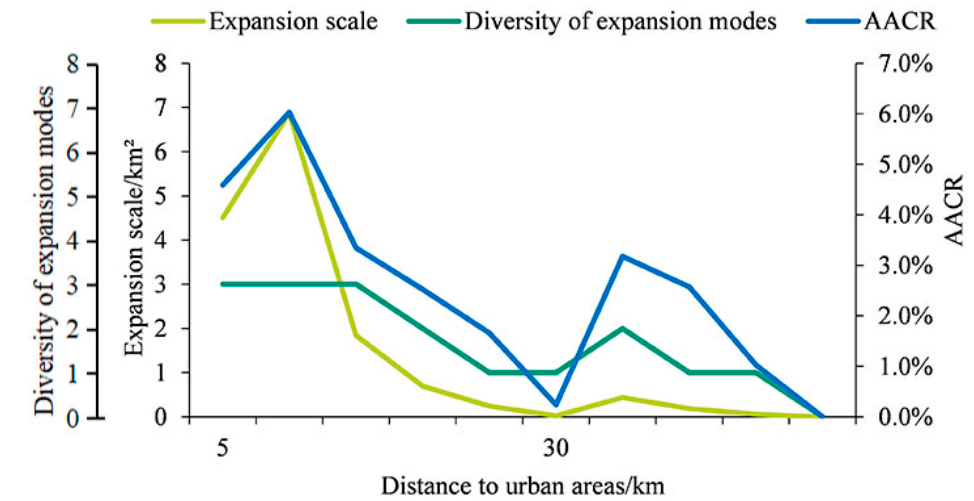
Figure 5. Rural residential land expansion characteristics within different buffer distances.